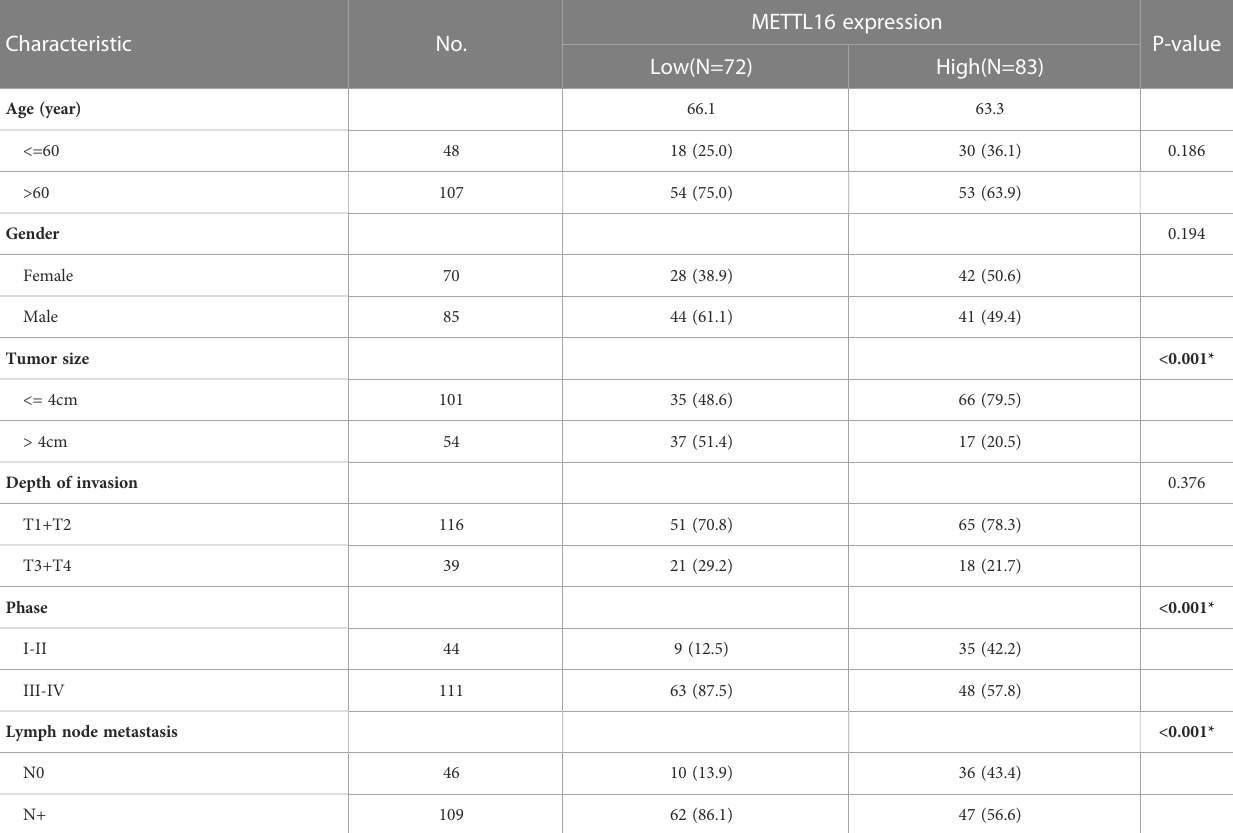
TABLE 1 Associations of METTL16 expression with clinical parameters in pancreatic cancer.